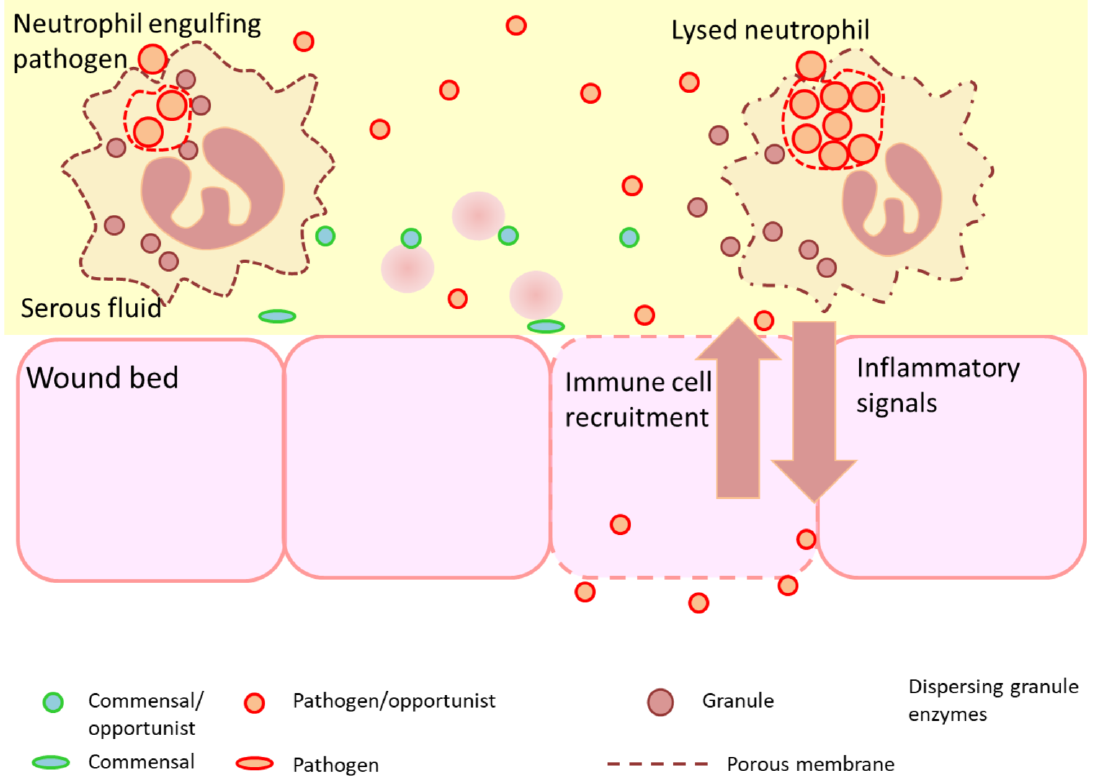
Figure 4. Early onset acute infection is associated with the lysis of immune cells by excess numbers of microorganisms, or the presence of organisms secreting toxins or virulence (pathogenicity) factors that inhibit immune function or injure host cells in the wound bed (e.g., pore-forming toxins). The polymicrobial nature of complex wounds will vary and may be dominated by fewer species over time if selective conditions arise (e.g., hypoxia, intra-microbial competition, use of antibacterial drugs). Toxins can also affect the wound bed and injure tissue. The potency and concentration of toxins are one of the factors that dictate the number of organisms necessary to establish an infection [92].